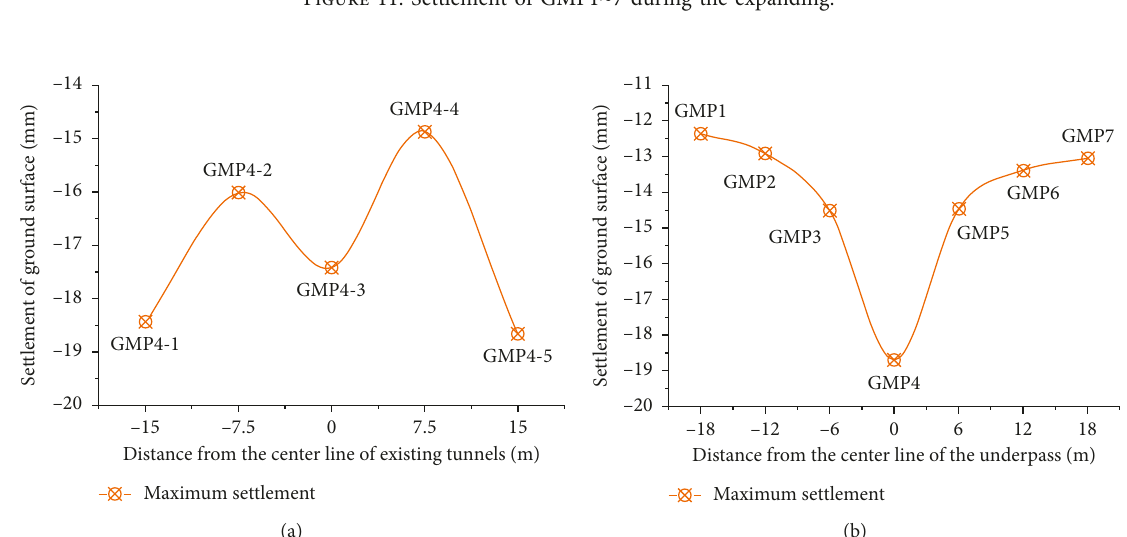
Figure 11: Settlement of GMP1 ∼ 7 during the expanding.